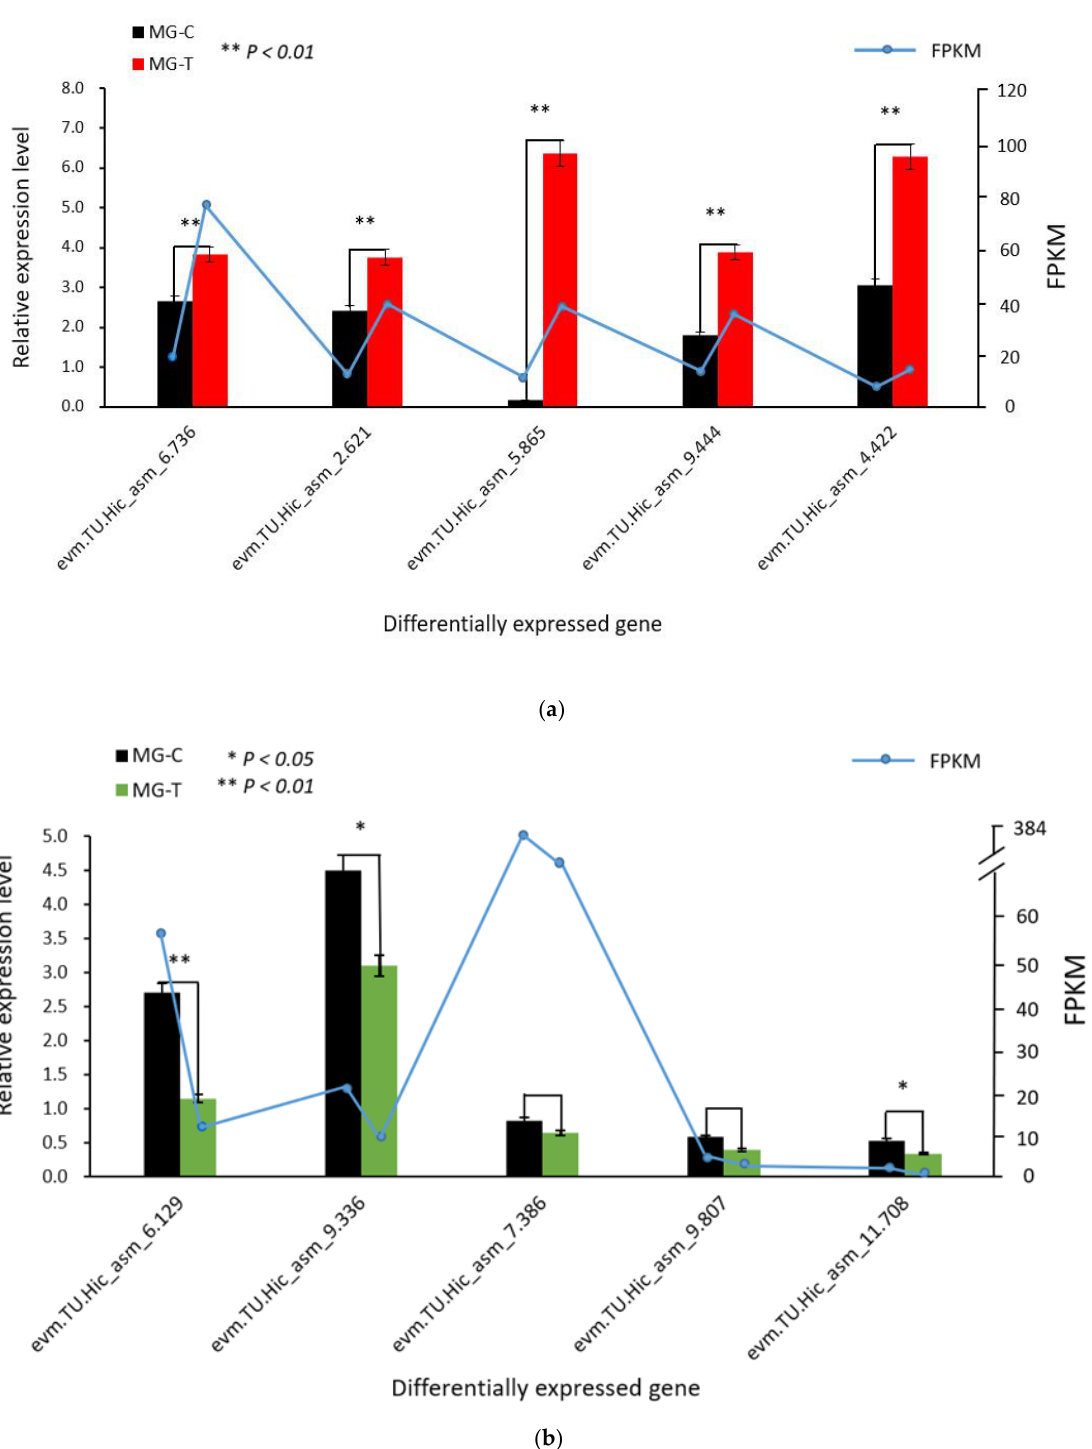
Figure 1. Ten DEGs verified by qRT-PCR: ( a ) up-regulated DEGs; ( b ) down-regulated DEGs. Note: The x axis is differentially expressed genes, the left y axis represents relative gene expression, and the right y axis represents FPKM value.